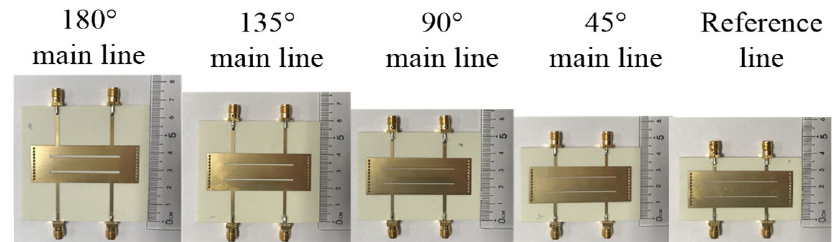
Figure 10. The photograph of the proposed balanced SIW phase shifter.